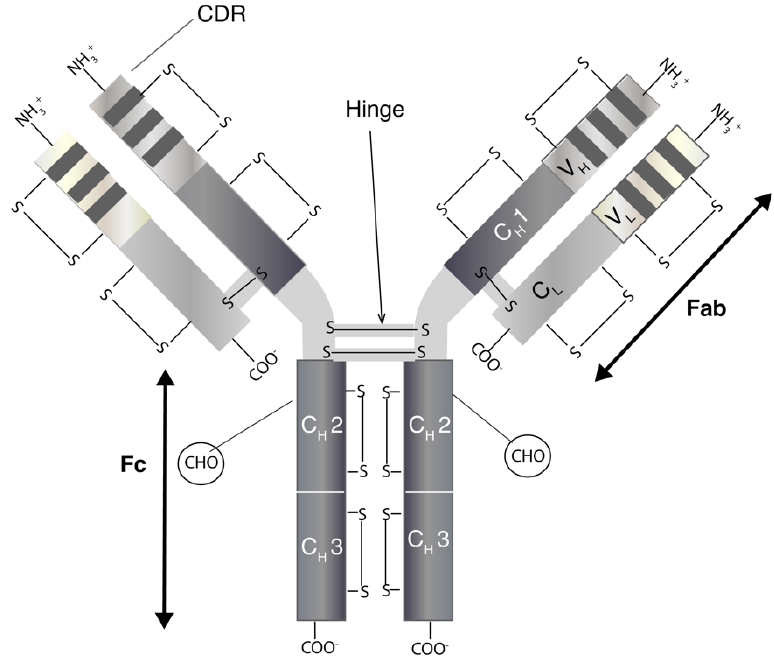
Figure 1. A schematic diagram representing the modular structure of a monoclonal antibody